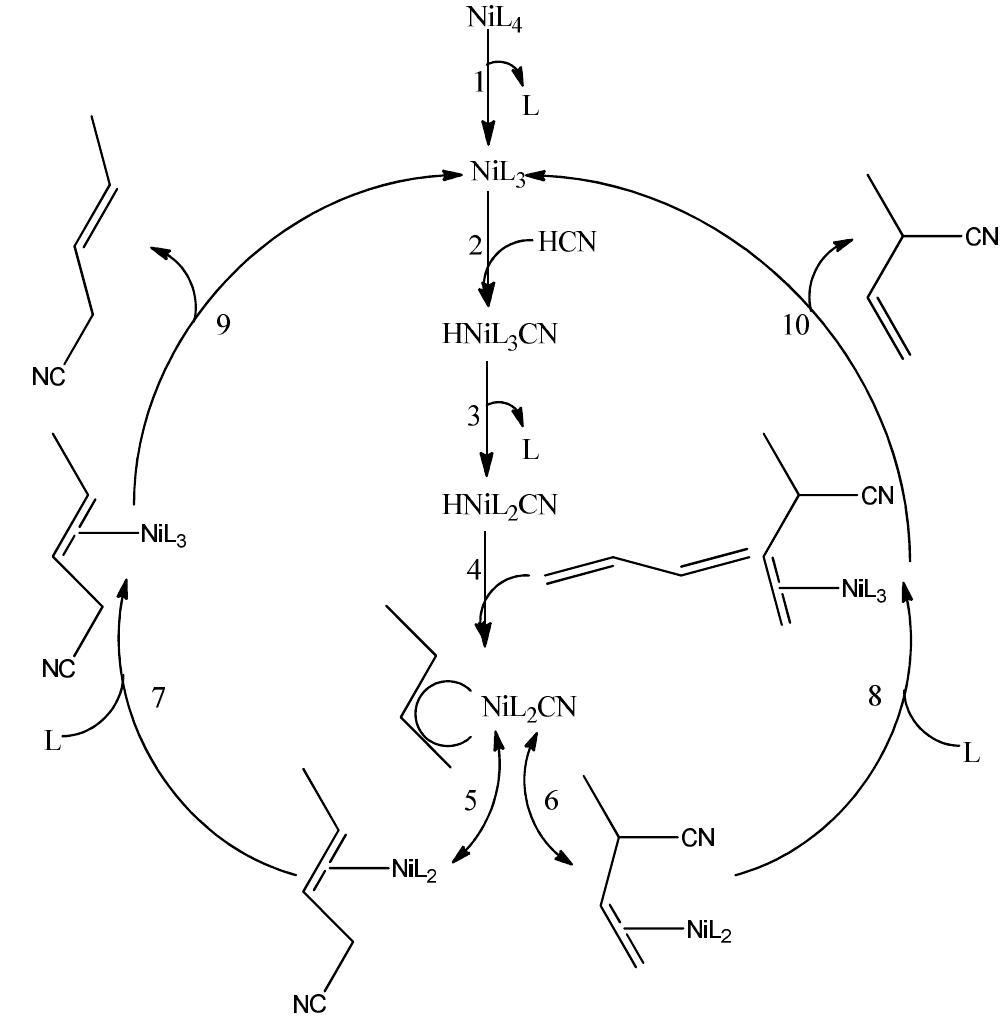
Figure 3. Mechanism of butadiene hydrocyanation [38].